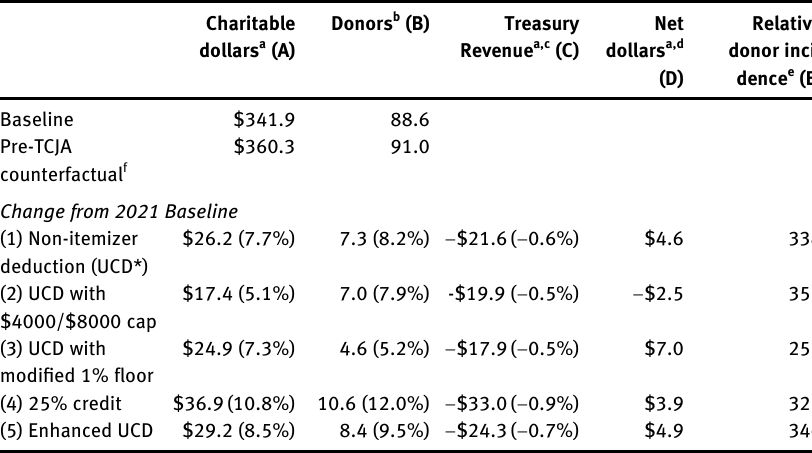
Table  : Summary of effects of fi ve policy options on charitable giving and number of donors, 